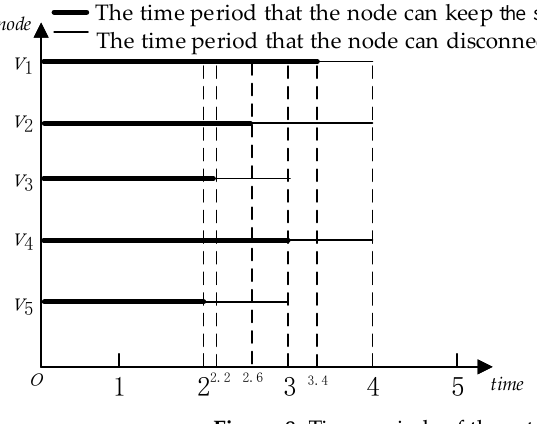
Figure 8. Time periods of the set L